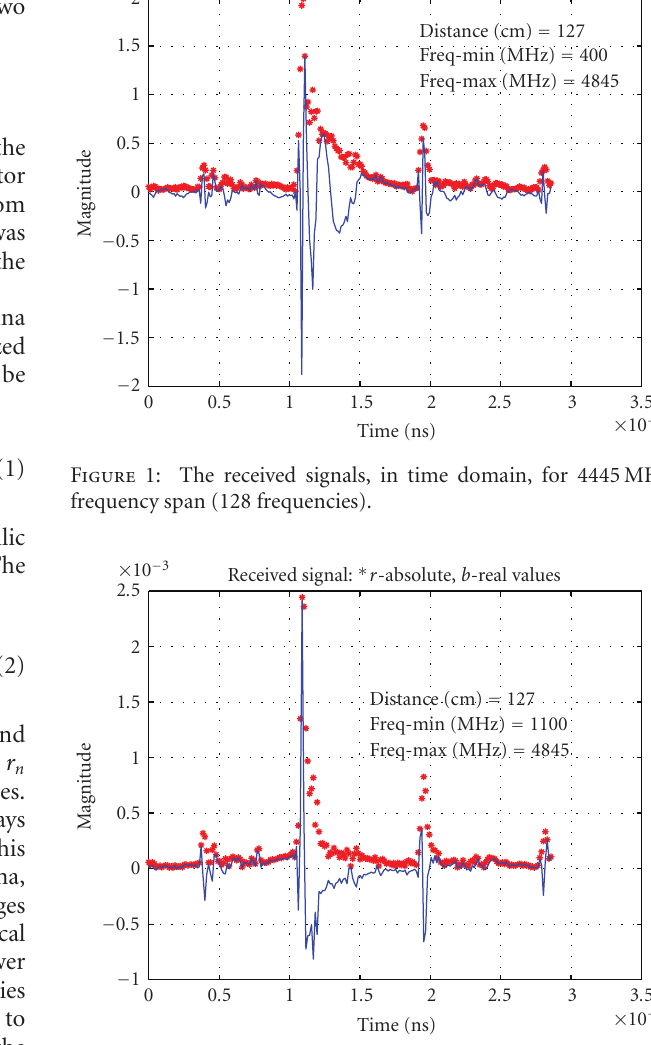
Figure 2: The received signals, in time domain, for 3745 MHz frequency span (108 frequencies—first 20